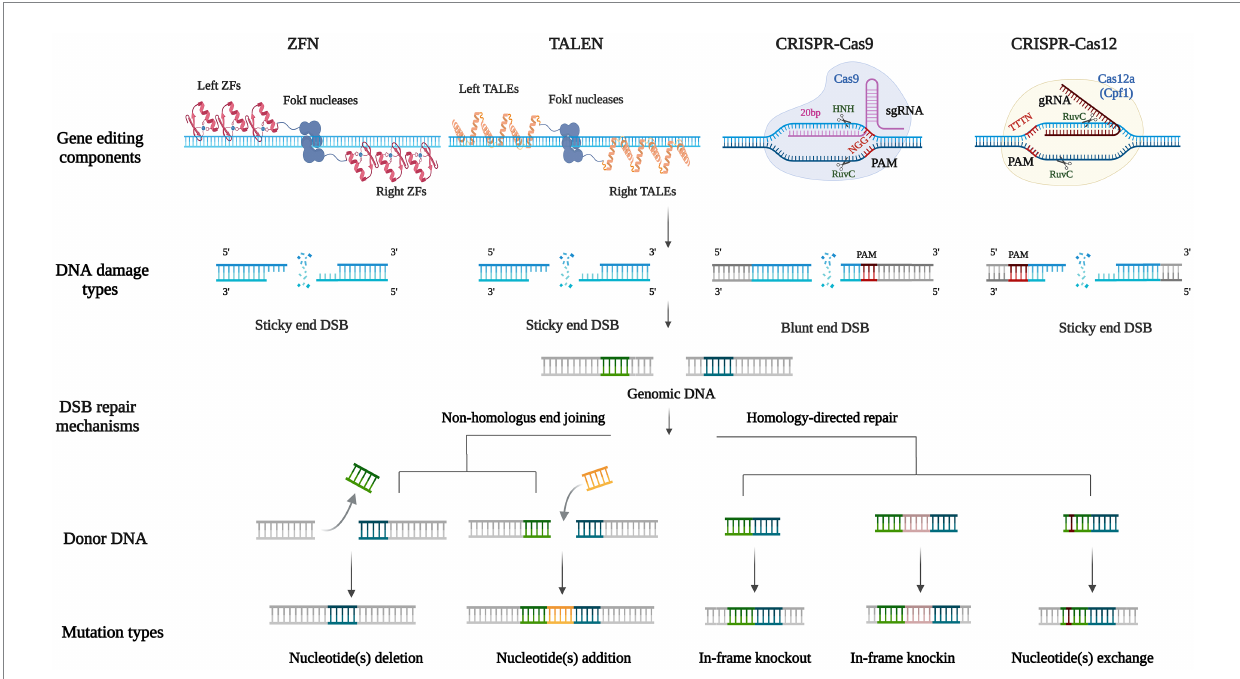
FIGURE 3 Biological mechanisms for nuclease-based gene editing technologies. Including gene editing components, the type of DNA damage, double-strand break repair mechanisms, donor DNA, and mutation types of ZFN, TALEN, CRISPR-Cas9, and CRISPR-Cas12 systems. Both ZFN and TALEN systems locate similar FokI endonucleases (the dark blue combined sphere) by DNA-binding domains on the left and right of the target site (the red zinc finger domains and the yellow transcription activator-like effectors domains), producing sticky ends double-strand breaks. The CRISPR systems consist of guiding RNA to locate target fragments containing PAM (the bases highlighted in red), and Cas nuclease domains cleave DNA to produce double- strand breaks. Cas9 includes HNH and RuvC catalytic nuclease domains, each cleaving one strand of the target DNA to produce a blunt end. Cas12 contains a RuvC nuclease domain that acts on both single strands of the target DNA to produce a sticky end. NHEJ and HDR are two DSB repair mechanisms, based on the complementarity of homologous fragments between genomic DNA and donor DNA (base pairs of the same color), to produce different mutation types including nucleotide(s) deletion, nucleotide(s) addition, in-frame deletion, in-frame knockout, and nucleotide(s)